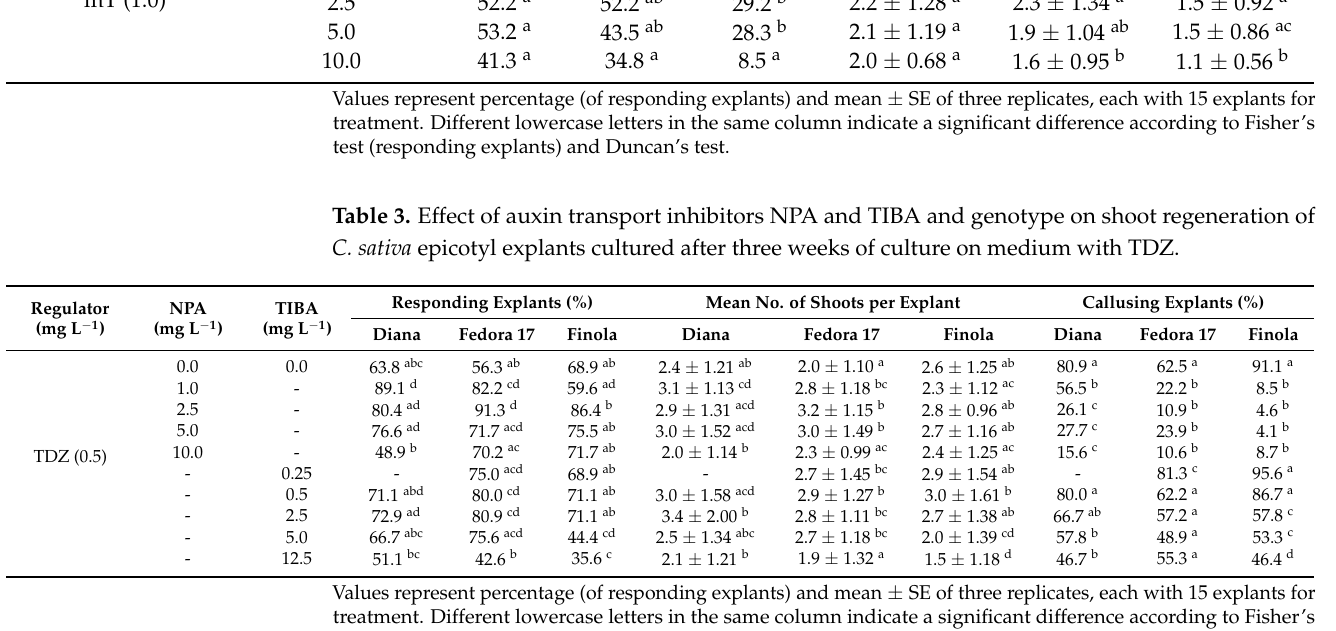
Values represent percentage (of responding explants) and mean ± SE of three replicates, each with 15 explants for treatment. Different lowercase letters in the same column indicate a significant difference according to Fisher’s test (responding explants) and Duncan’s test. Table 4. Effect of different treatment variants (inhibitors, TDZ concentration, time of cultivation) on